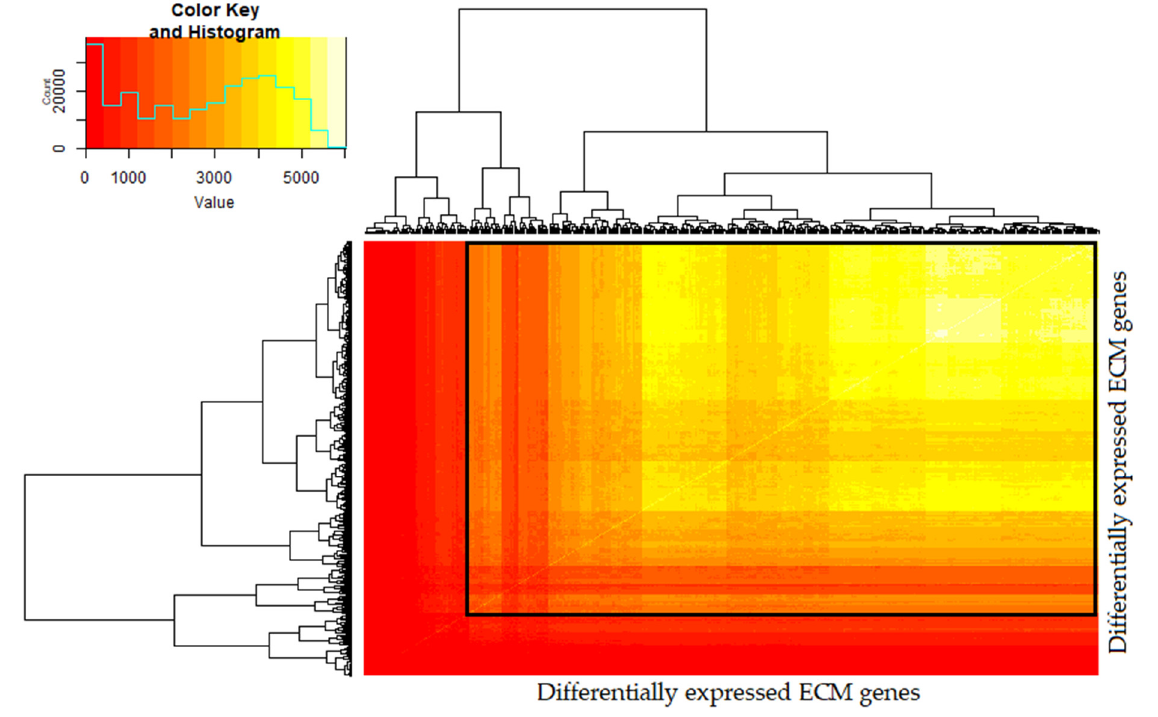
Figure A7. Hypernetwork heatmap of ECMs ( n = 502 transcripts) in PDAC stroma and epithelium. Colour intensity represents the number of binary relationships shared between a pair of transcripts with the rest of the transcriptome ( n = 13,322 total transcripts). Two clusters were identified, with cluster 1 having 376 ECMs with a higher connectivity (highlighted in black box) and cluster 2 having 126 ECMs with relatively fewer correlations with the rest of the transcriptome.